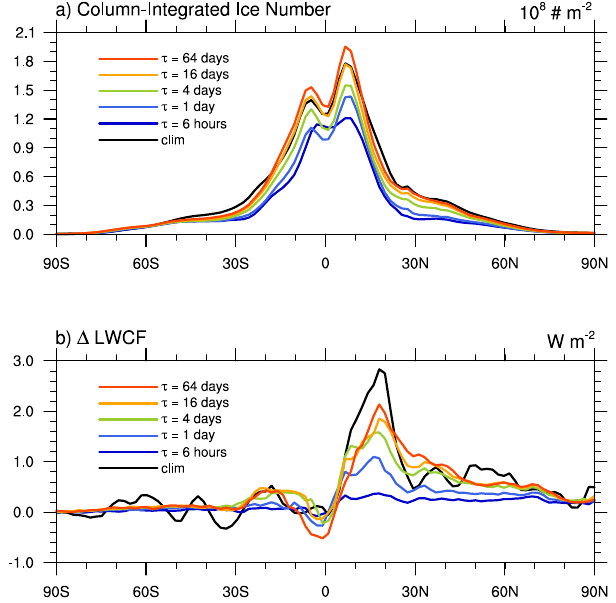
Figure 5. Sensitivity of zonal and annual mean (a) present-day ice crystal number concentration in the upper troposphere (vertical inte- gral between 100hPa and 300hPa, unit: 10 8 m − 2 ), and (b) aerosol induced long-wave cloud forcing change (PD–PI, unit: Wm − 2 ), to the temperature relaxation time scale τ T in CAM5 simulations where temperature and horizontal winds were nudged towards the ERA-Interim reanalysis.